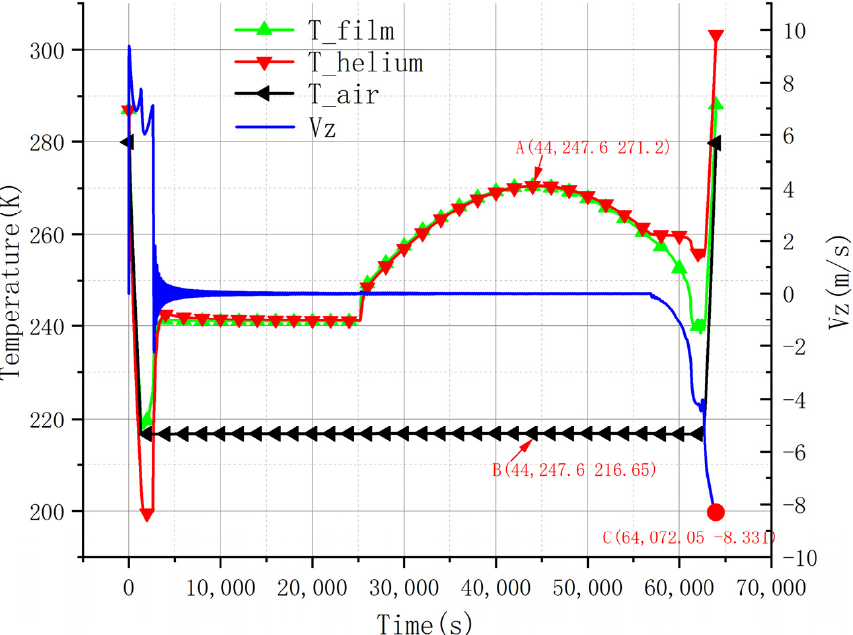
Figure 9. Temperature change of the film, helium, and air vs. time, and the change of the vertical speed of the balloon flight system vs. time.